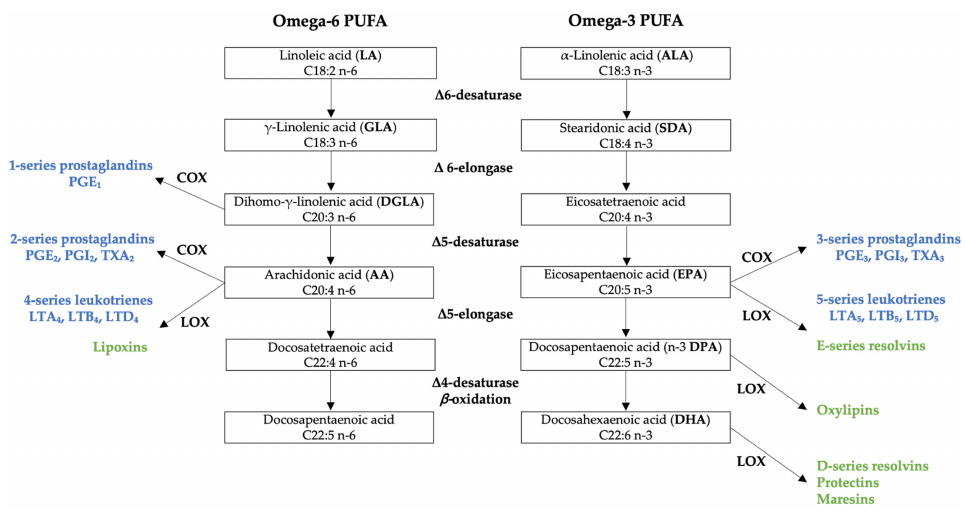
Figure 1. Metabolic routes undergone by omega-6 and omega-3 polyunsaturated fatty acids (PUFA) as precursors of eicosanoids (in blue) and specialized pro-resolving lipid mediators (SPMs, in green). COX: cyclooxygenases; LOX: